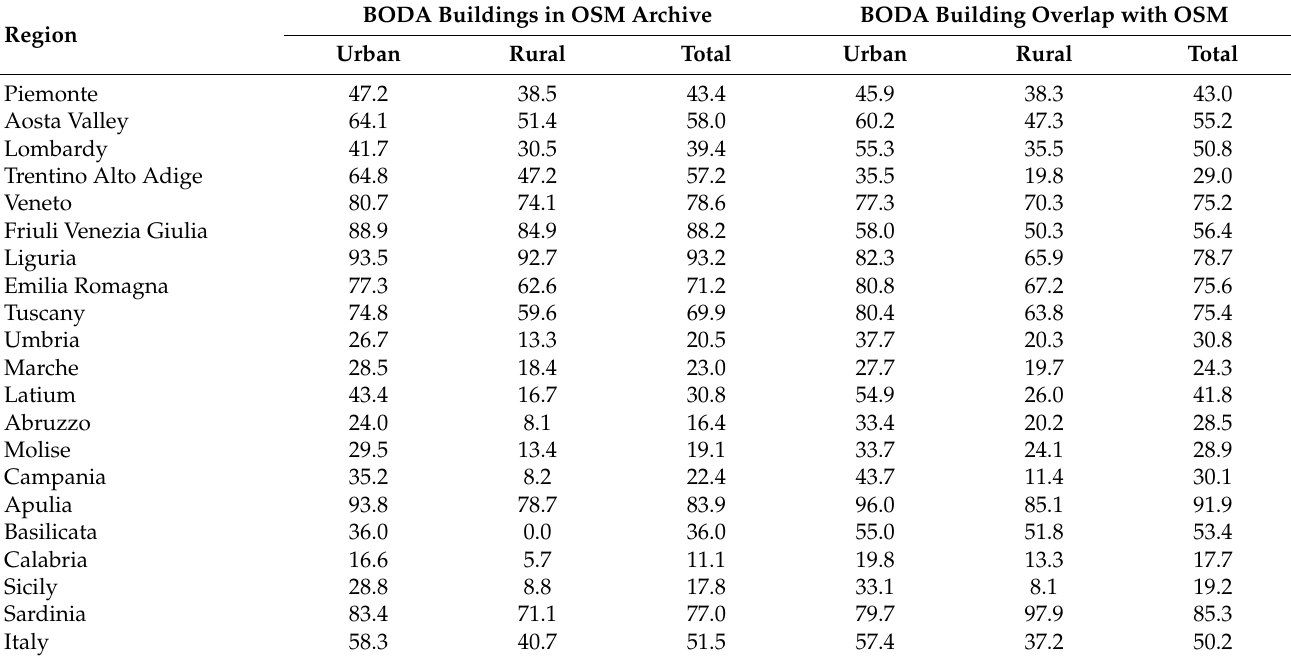
Table 4. ( Left ) Percent share of BODA buildings found in the OSM archive in total BODA coverage; ( right ) percent share of OSM building area that overlaps with BODA building area in Italy in total OSM building area, by administrative region and urban/rural district.